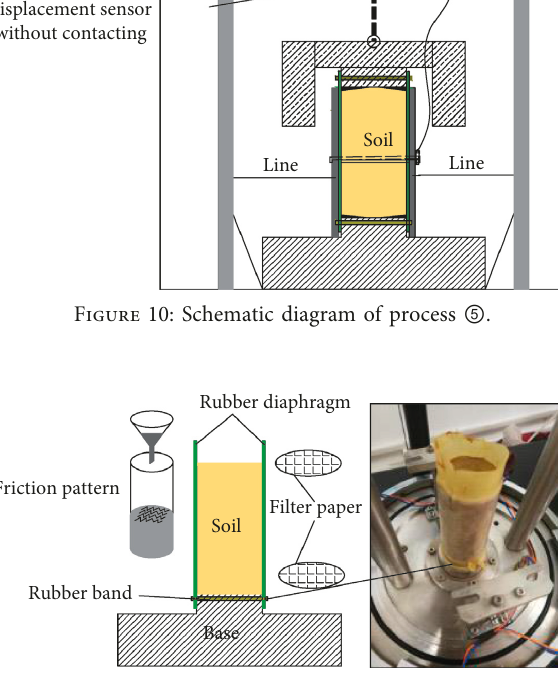
Figure 11: Schematic diagram of process ① .